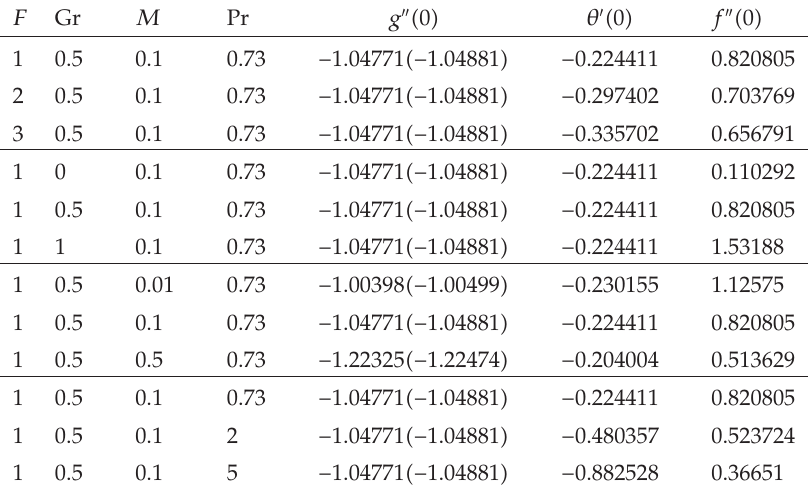
Table 2.1 . Variation of f (cid:6)(cid:6) , g (cid:6)(cid:6) , θ (cid:6) at the plate surface with F , Gr, M , and Pr